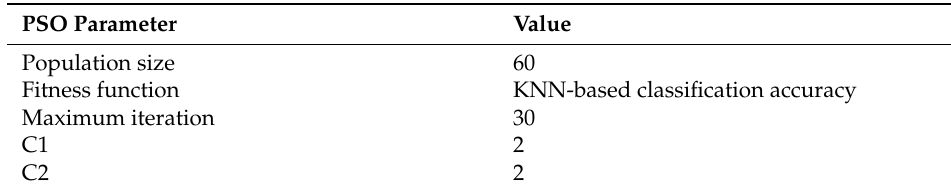
Table A9. Parameters used in PSO for selecting optimum features.